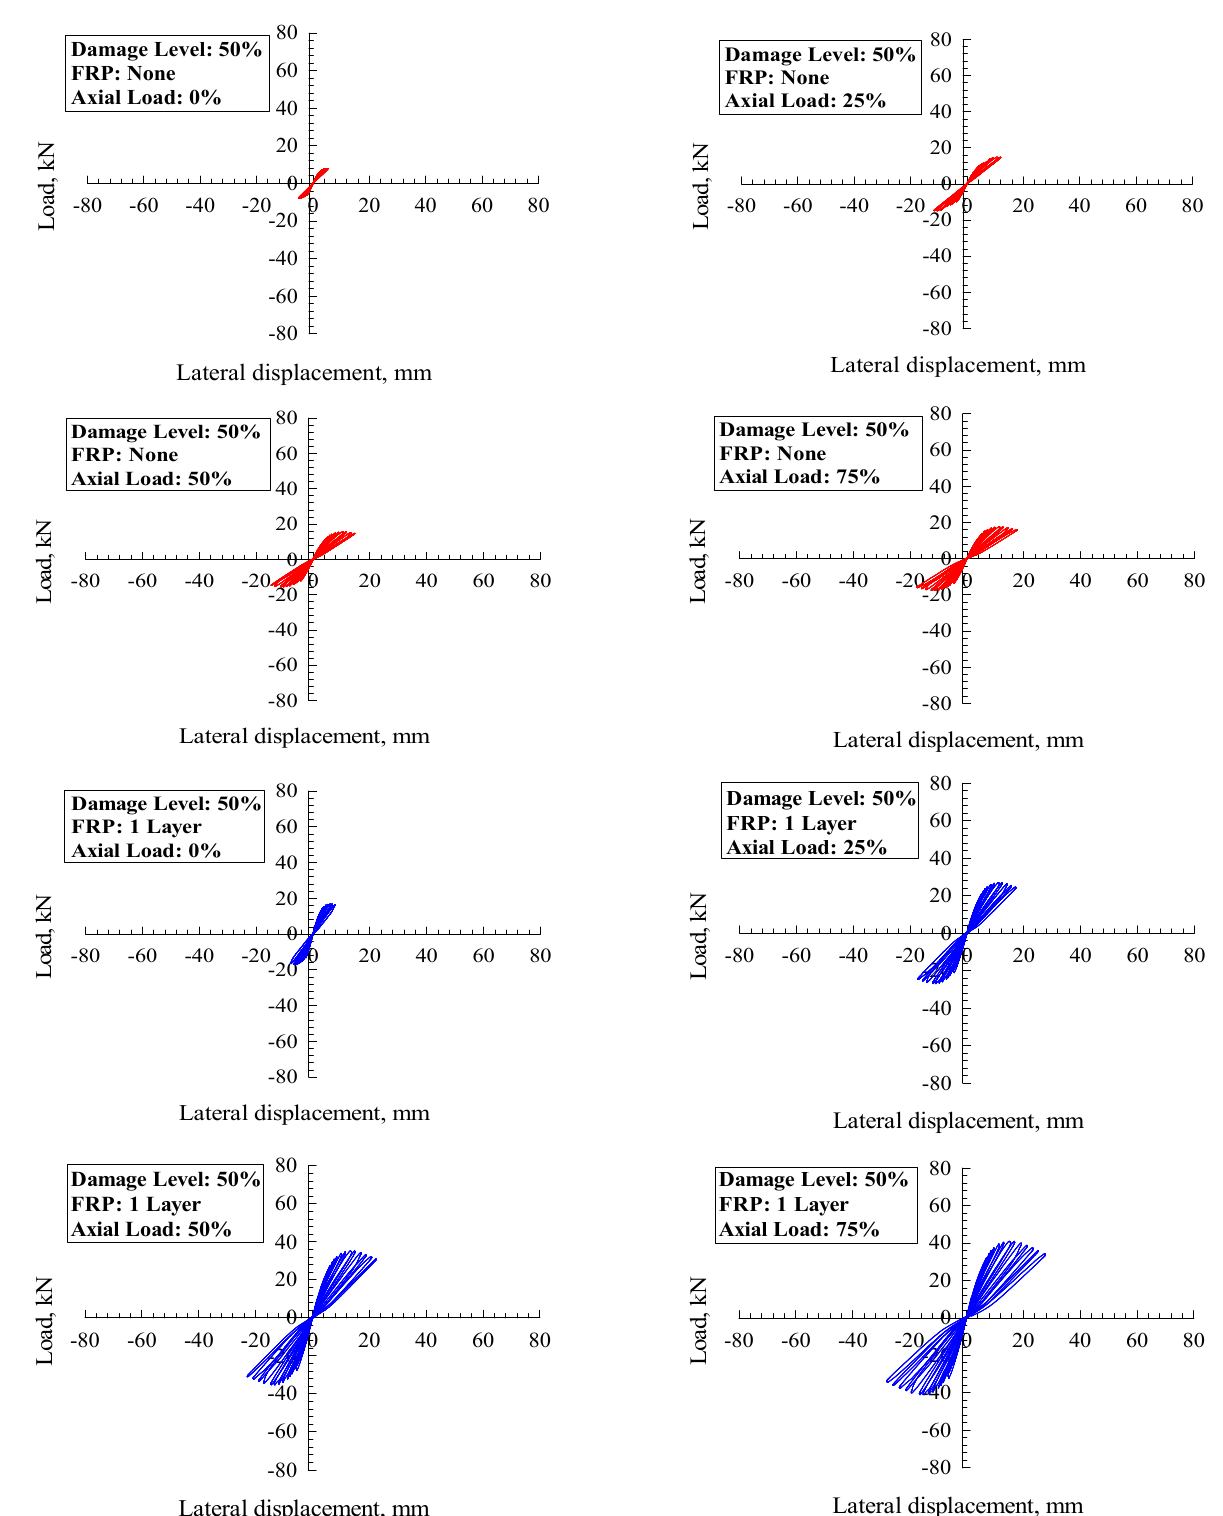
Figure 10. Hysteretic loops for 50% damaged joints.